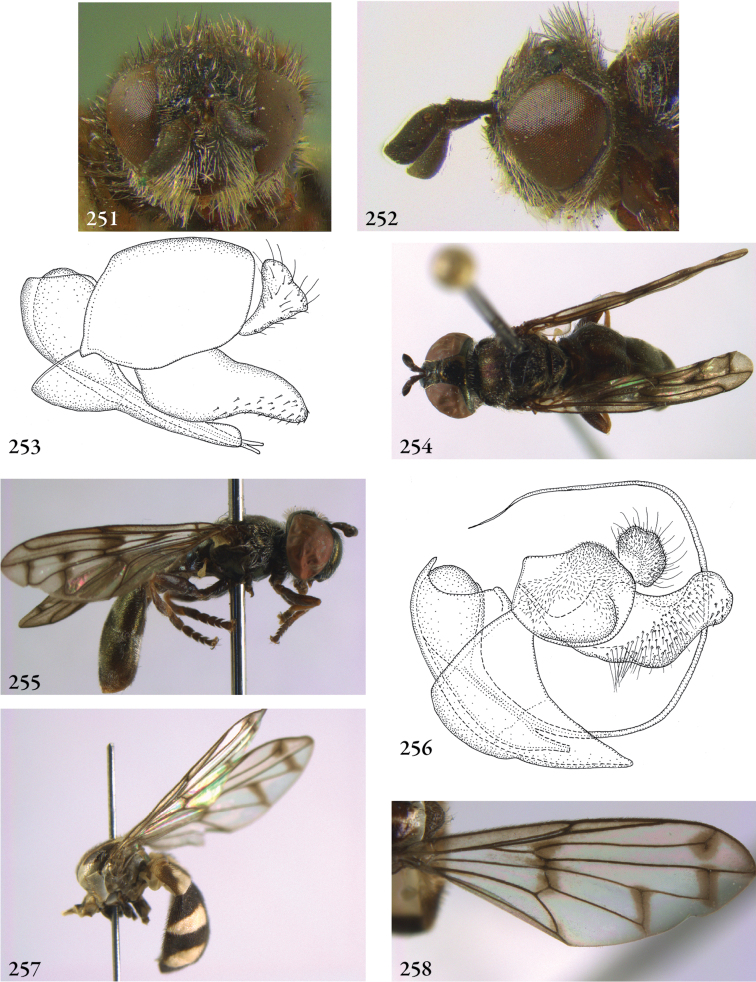
251–252
Oligeriops iridomyrmex female (syntype): 251 head frontal 252 head lateral 253
Oligeriops dimorphon male (Australia, coll. USNM), genitalia lateral 254–255
Omegasyrphus pallipennis male (USA, California, coll. RMNH) 254 habitus dorsal 255 habitus lateral 256
Omegasyrphus coarctatus male (USA, Virginia, coll. RMNH), genitalia lateral. 257–258
Paragodon paragoides female (Costa Rica, coll. RMNH): 257 habitus lateral 258 wing.